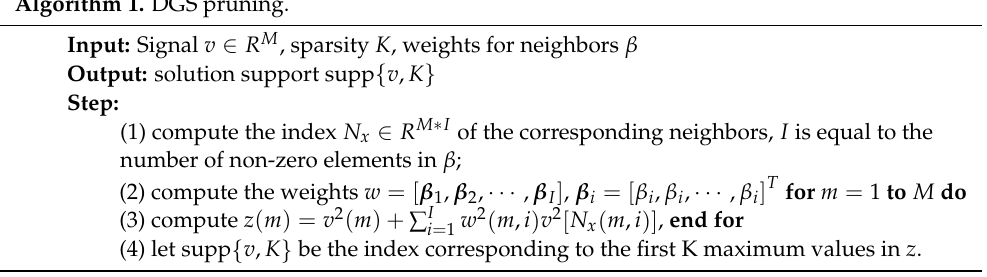
Figure 3. Group structures used in the DGS Pruning algorithm: ( a ) cross-shape structure, ( b ) vertical structure, ( c ) horizontal structure, ( d ) eight neighbors structure. Algorithm 1. DGS pruning.